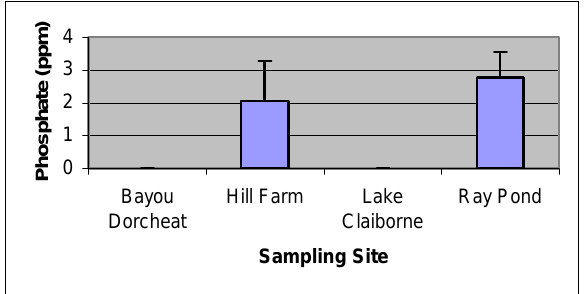
Figure 9: Mean (n=15) values of phosphate (ppm) levels at each sampling site.